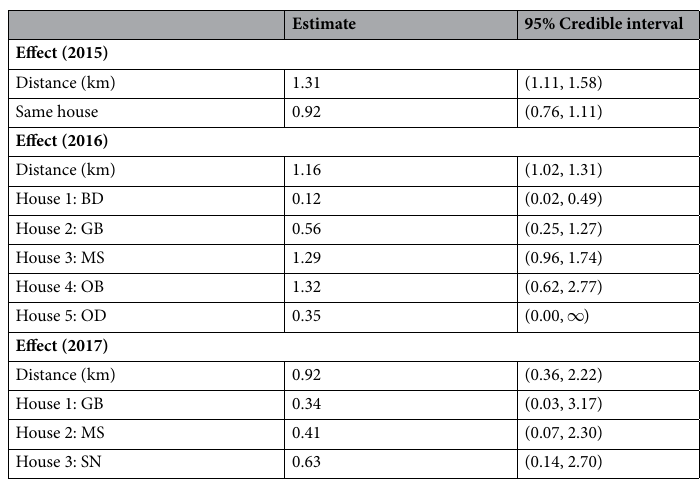
Table 2. Relationship between physical distance and genetic distance. The relationship between physical distance (measured in kilometers (km) between two GPS coordinates) and genetic distance (measured as identity by state, the number of barcode differences in the 24-SNP molecular barcode) are shown overall, as well as by household. Estimates (posterior medians) are shown for the exponentiated regression parameters along with 95% quantile-based equal tailed credible